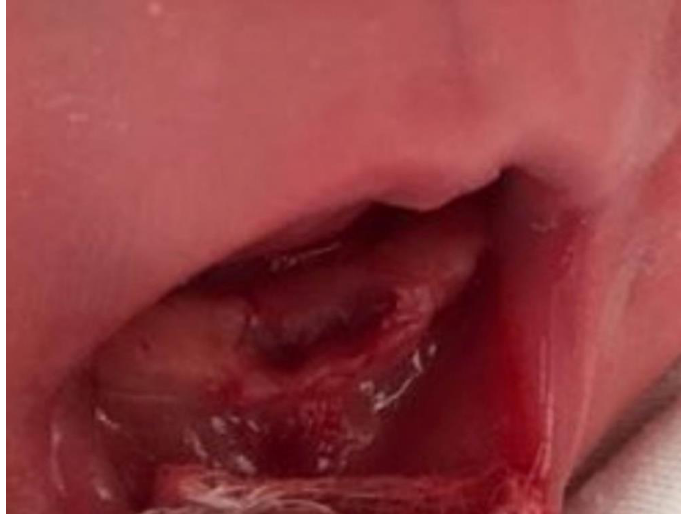
Table 1. Summary of the case report. Figure 3. Postoperative site. Figure 3. Postoperative site.